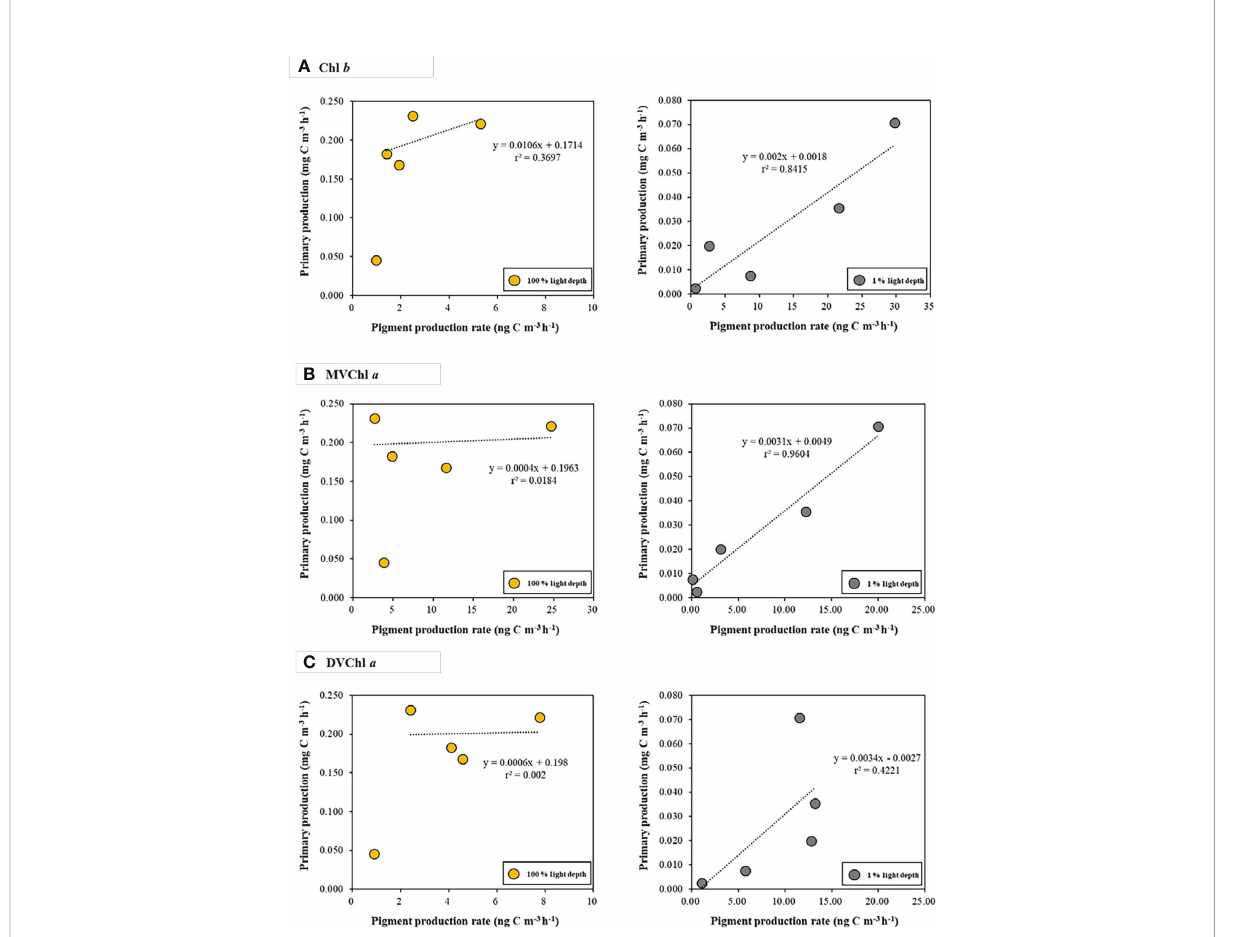
FIGURE 5 The relationships between photosynthetic pigment production rates (A) Chl b; (B) MVChl a; (C) DVChl a and primary production at the different light depths. Yellow and gray dots represent 100 % and 1 % light depths,